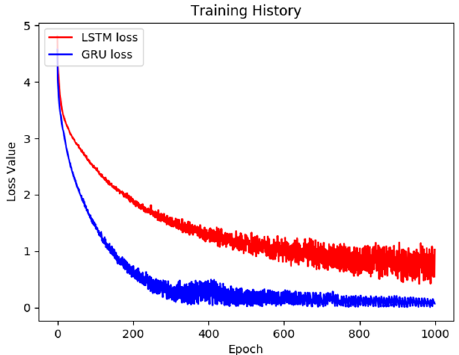
Figure 11. The learning curve of the chatbot model.